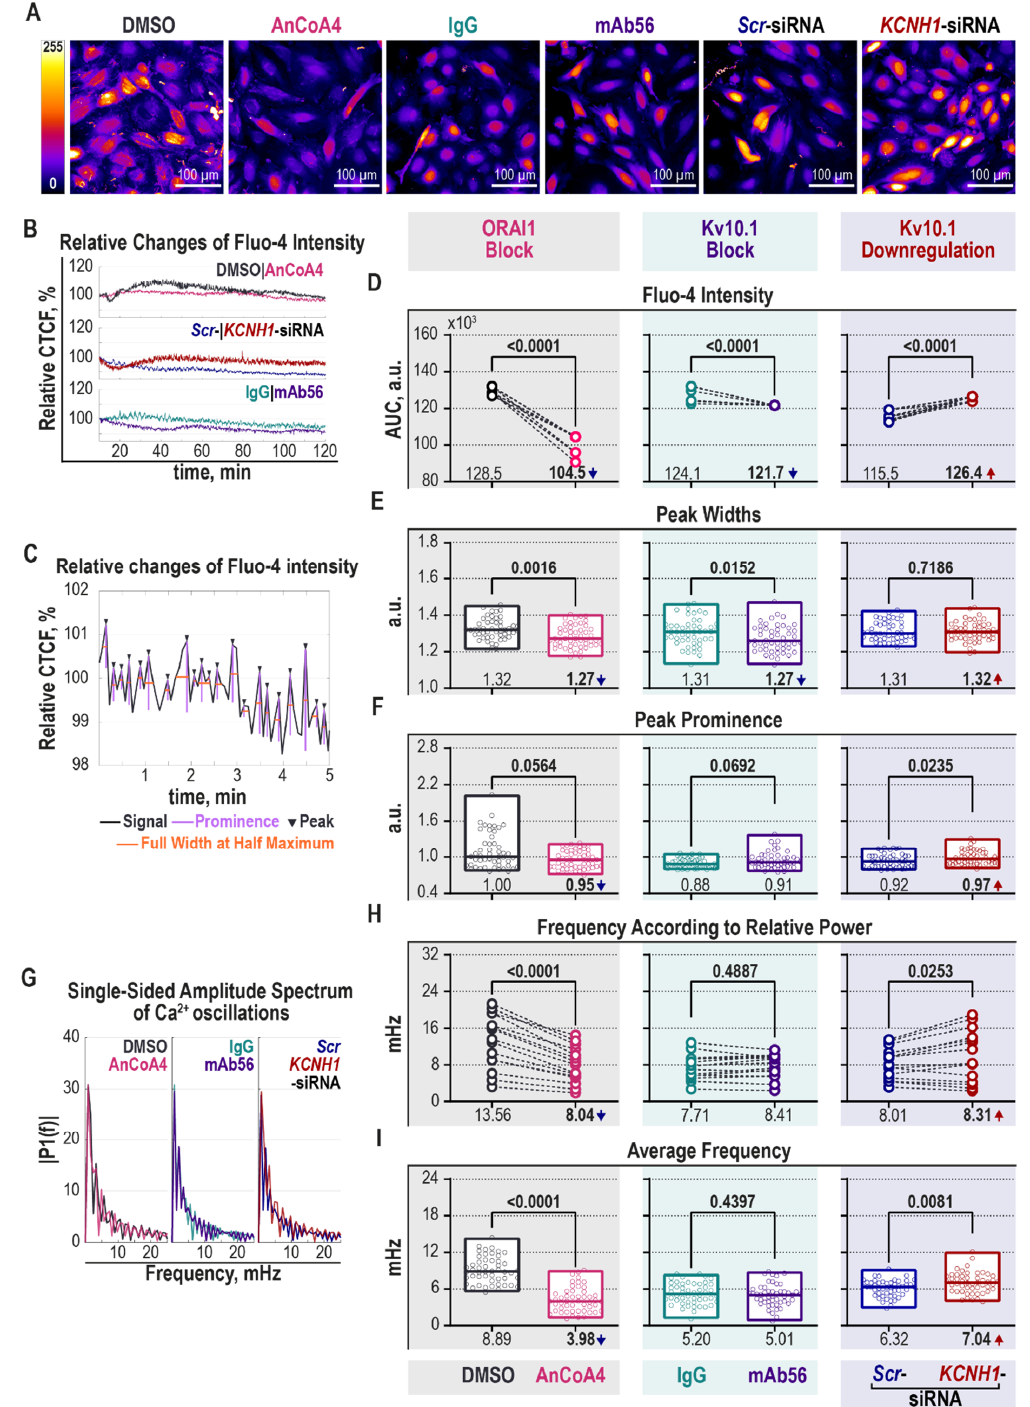
In contrast, the height of the peaks was not significantly a ff ected (left grey and middle turquoise panels, Figure 5F). Opposingly, Kv10.1 silencing produced more prominent spikes (right blue panel, Figure 5F), but did not change the duration of the peaks (right blue panel, Figure 5G).